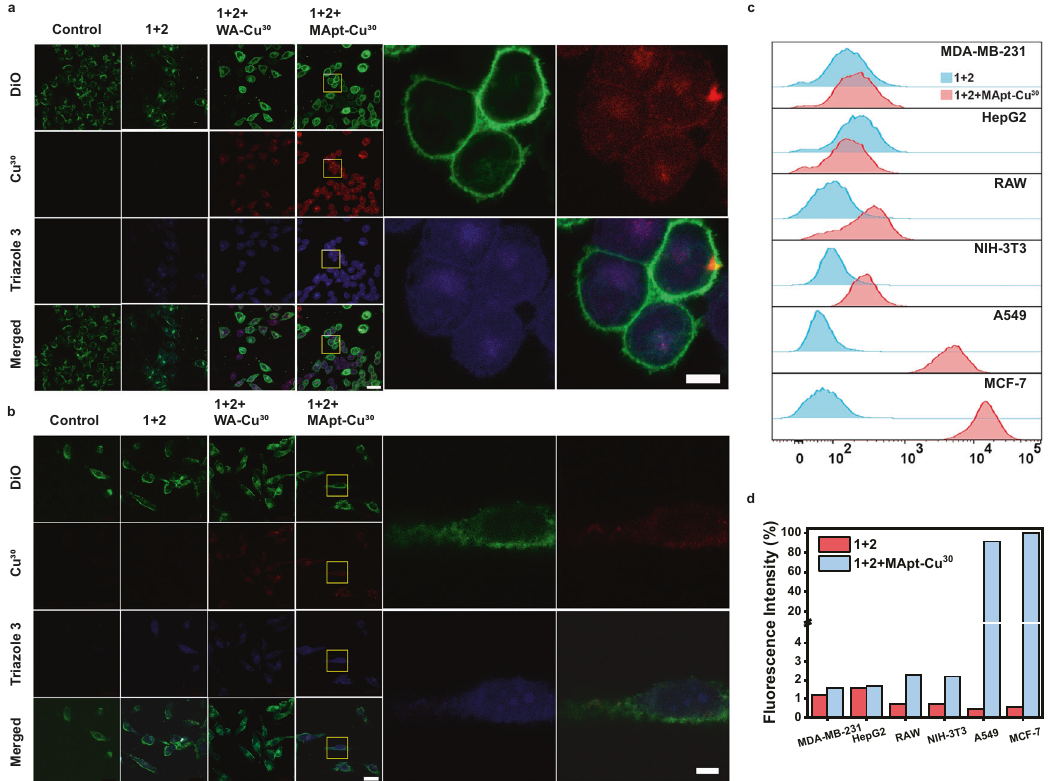
Fig. 4 CuAAC reaction catalyzed by MApt-Cu 30 in speci fi c-type cells. a , b Confocal microscopy images of MCF-7 and MDA-MB-231 cells treated with 1 + 2 , 1 + 2 + WA-Cu 30 , and 1 + 2 + MApt-Cu 30 , respectively. Images are representative of three independent biological samples. Scale bars, 50 μ m (main images), 10 μ m (High-resolution images of corresponding cells treated with 1 + 2 + MApt-Cu 30 ). c Flow cytometry assays of different cells treated with 1 + 2 , and 1 + 2 + MApt-Cu 30 . d Quantitative analysis of fl uorescence intensity of different cells treated with 1 + 2 , and 1 + 2 + MApt-Cu 30 by fl ow cytometry. Source data are provided as a Source Data fi